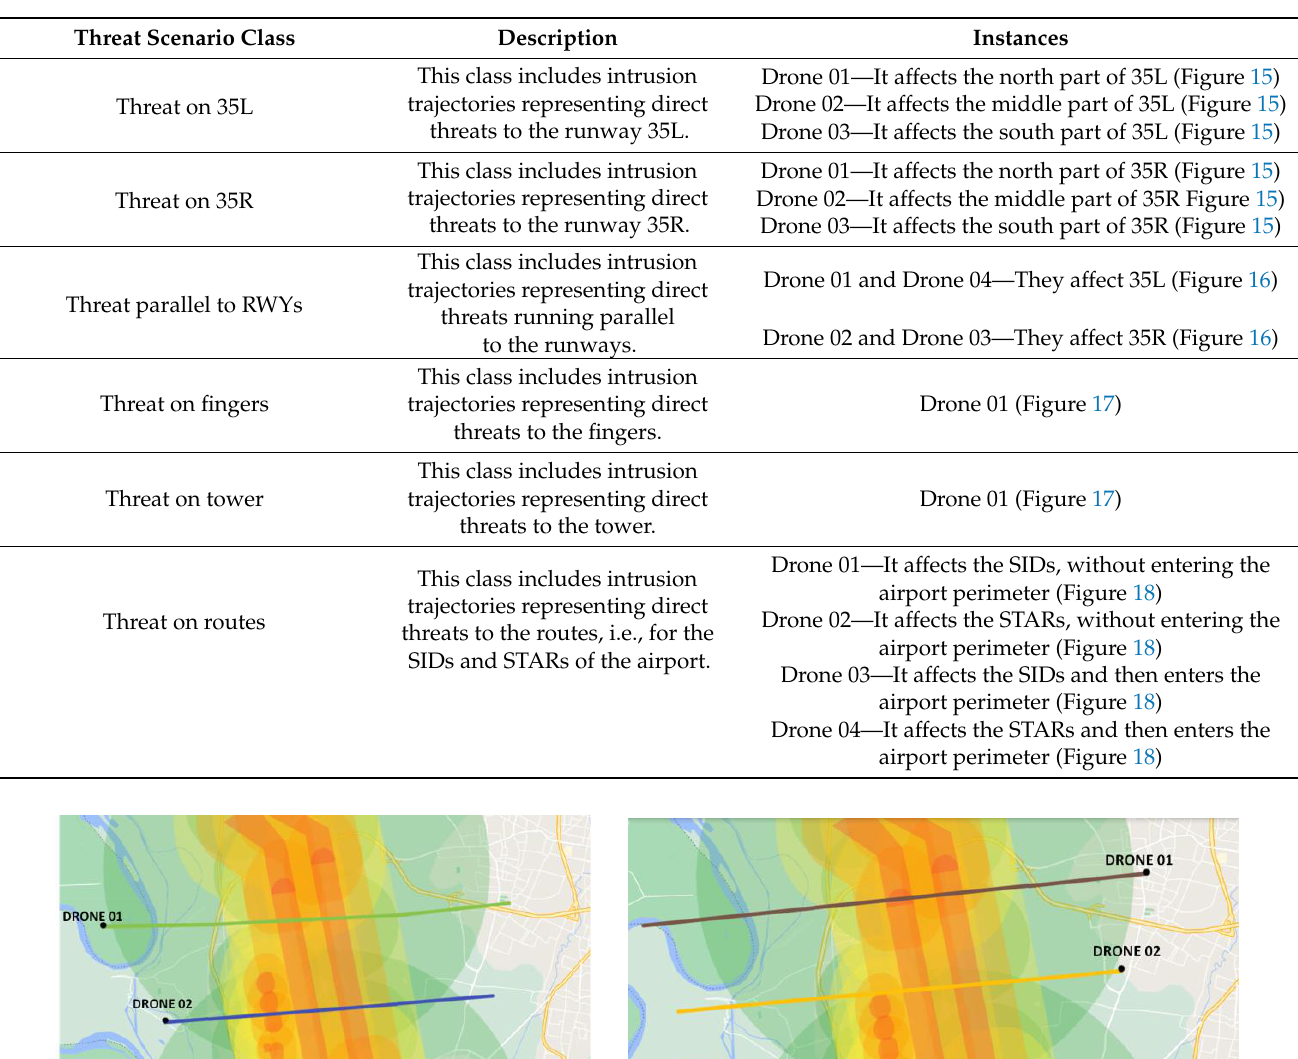
Table 3. Threat scenario classes and related instances for the proposed evaluation.